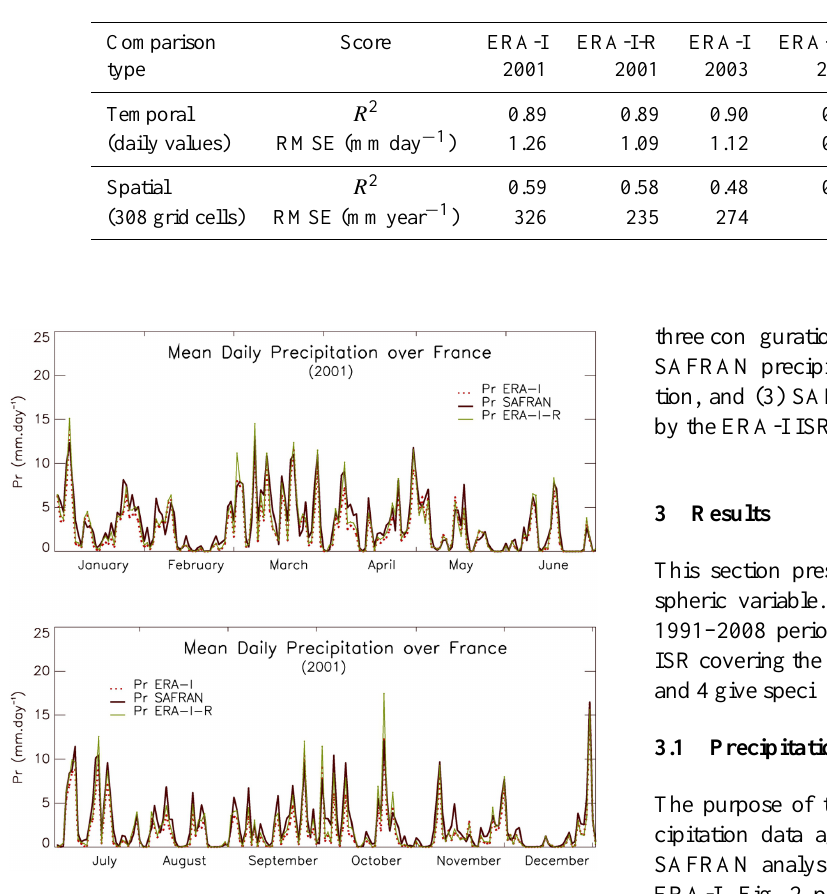
Table 1. Precipitation over France in 2001, 2003 and over the 1991–2008 period: temporal and spatial squared correlation coefficient and RMSE of ERA-I and ERA-I-R with respect to the SAFRAN analysis.